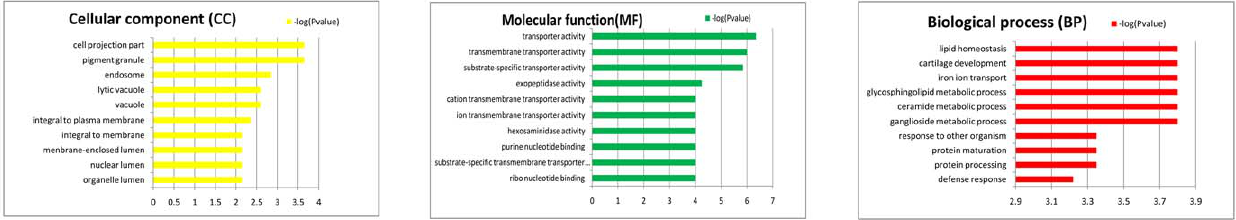
Figure 4. GO annotation of the final selected differentially expressed proteins. These differentially expressed proteins were classified among three categories: cellular component (CC), molecular function (MF) and biological process (BP). According to the GO database, the top 10 components for CC, MF, BP of the selected differentially expressed proteins are shown along with their enrichment score, represented as a p -value.